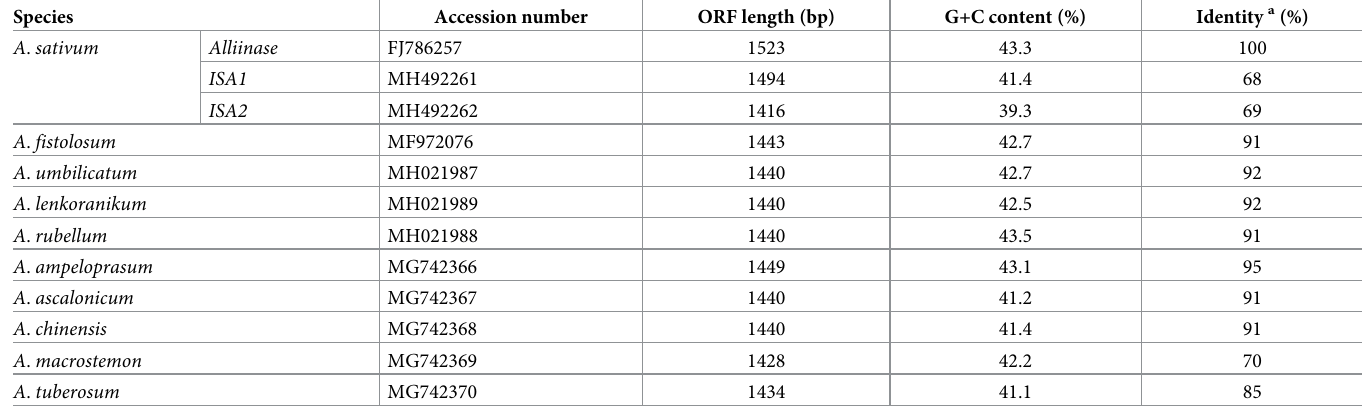
Table 1. Information of the identified alliinase gene from the different species.